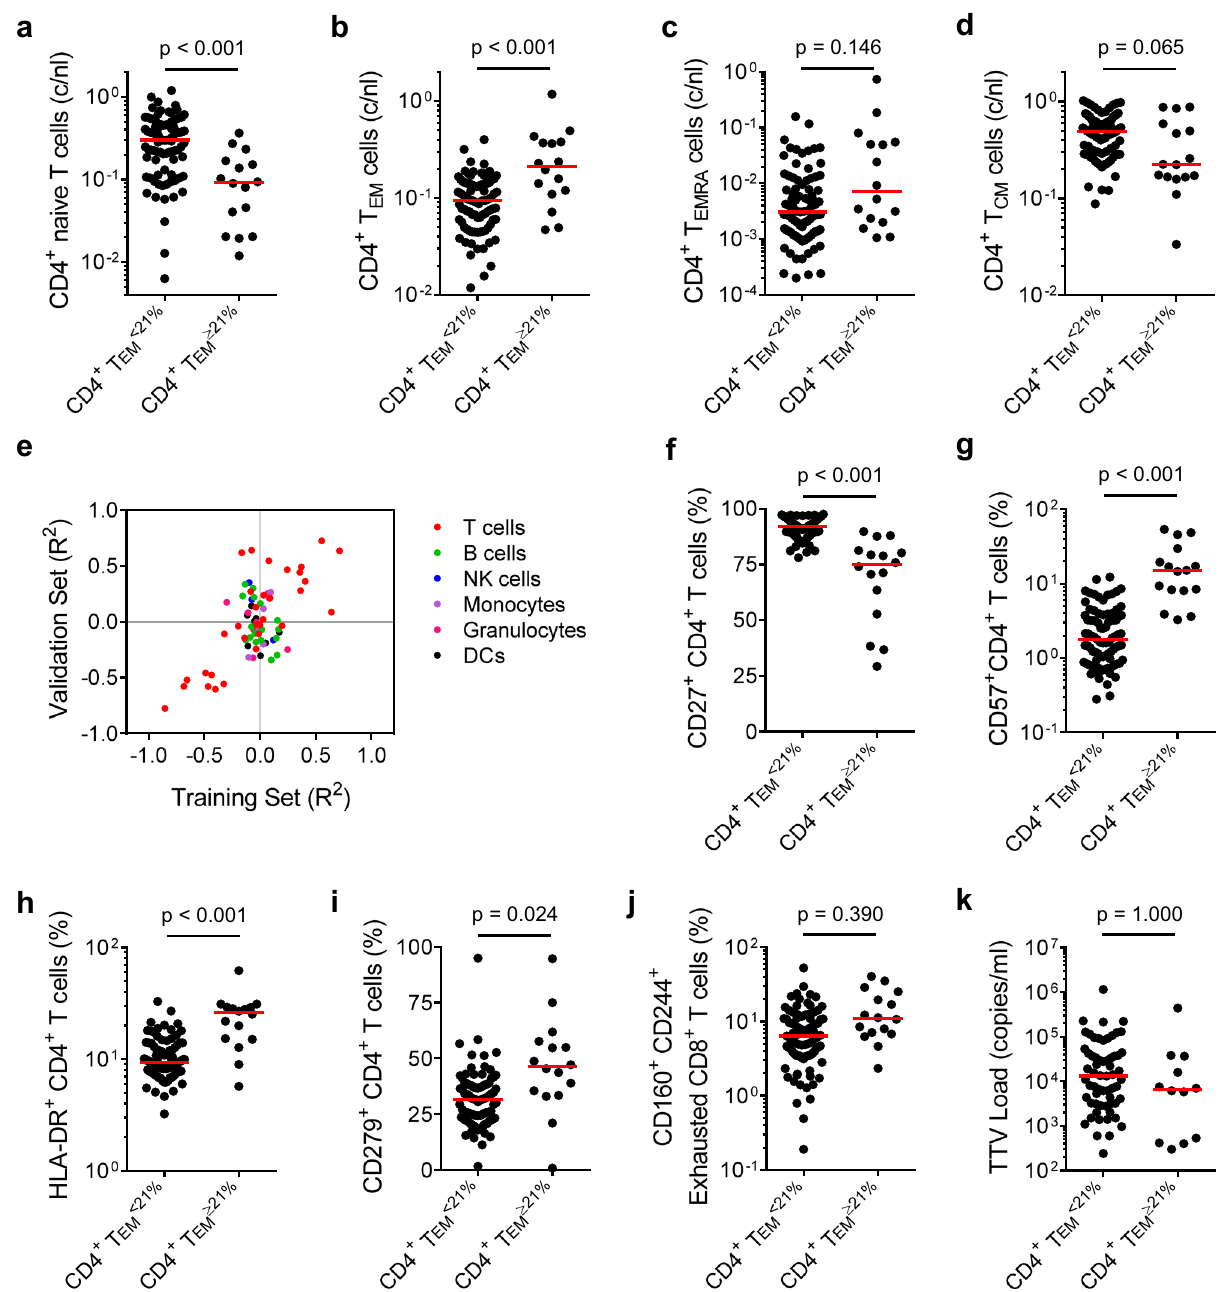
Fig. 4 CD4 + T EM cell enrichment is associated with chronic activation and increased numbers of effector memory CD4 + T cells. a – d Increased CD4